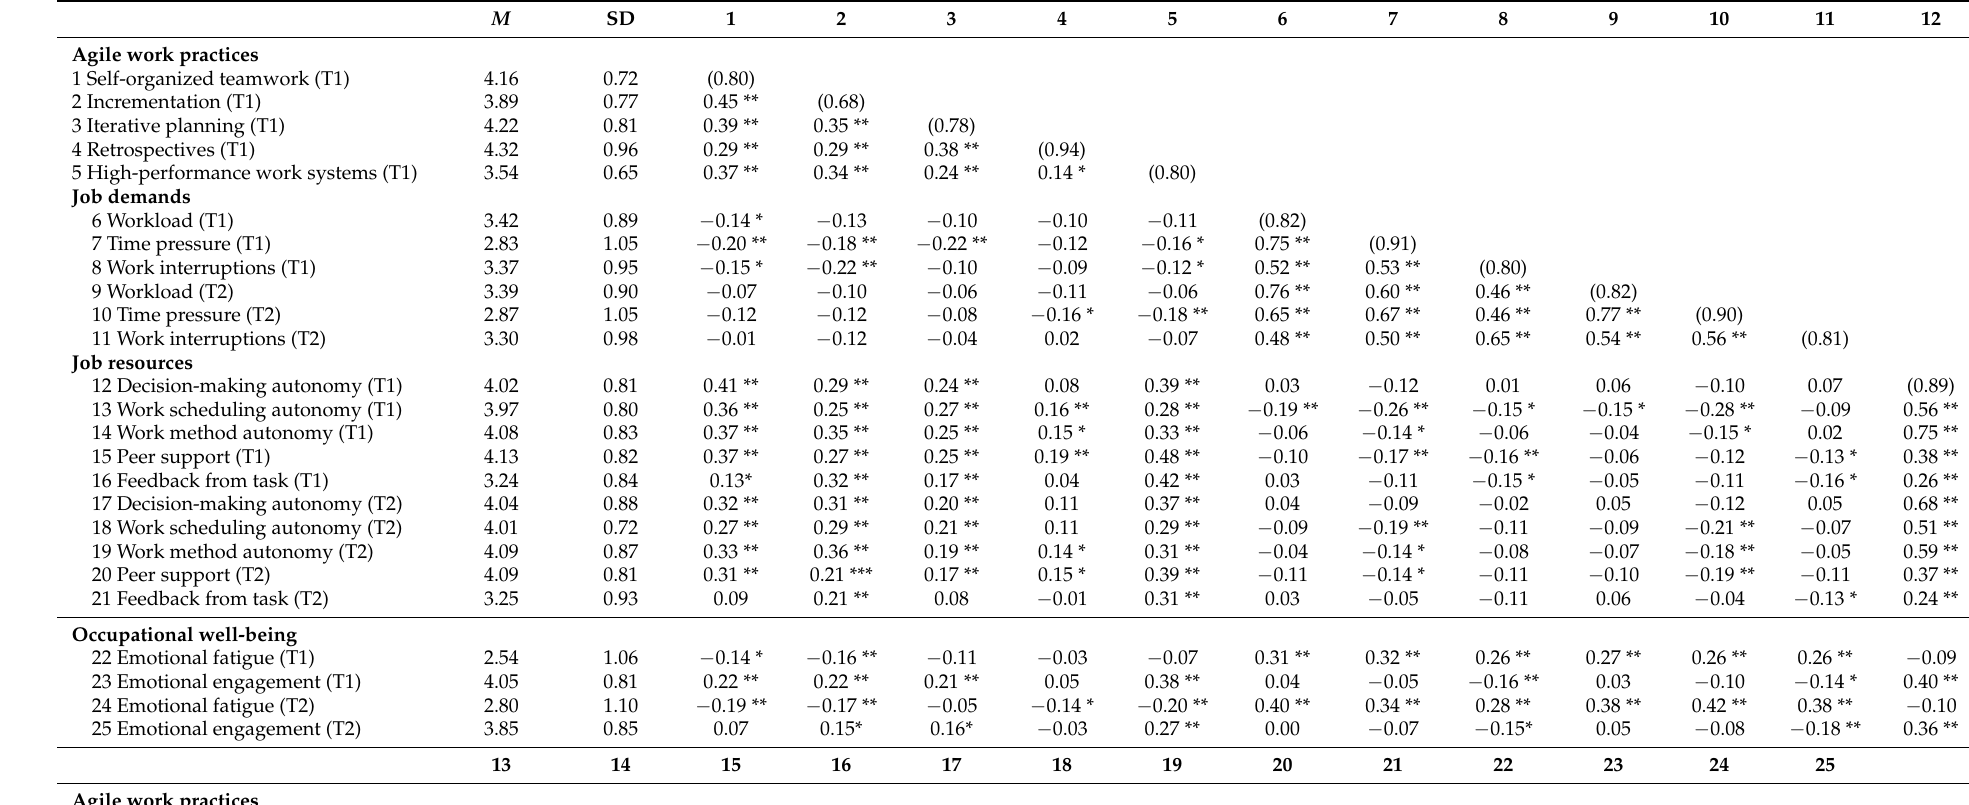
Table 1. Item means, item standard deviations, and correlations among the study variables. n = 260